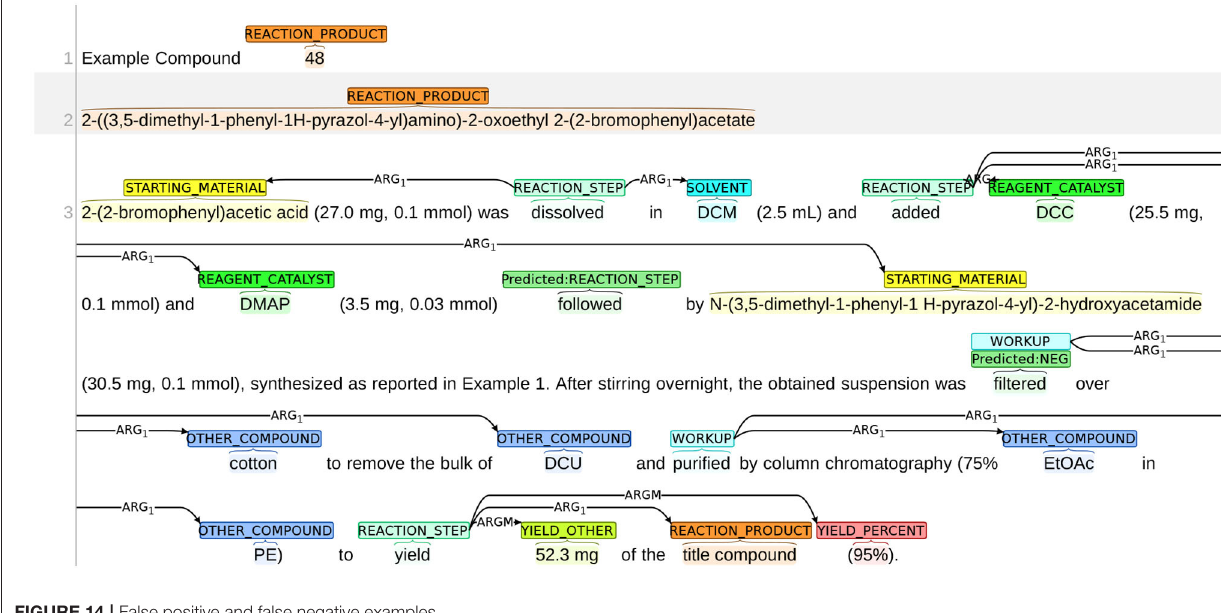
FIGURE 14 | False positive and false negative examples.